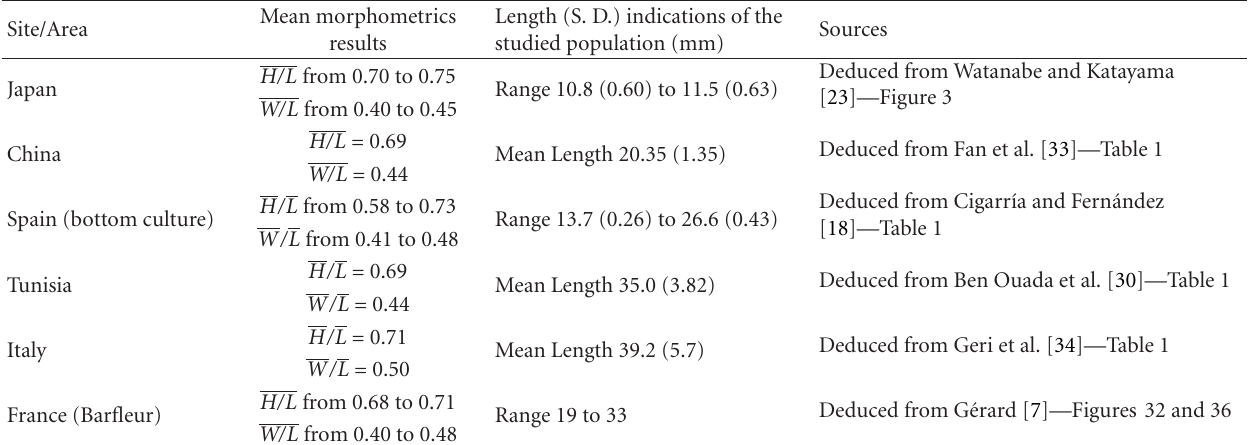
Table 3: Comparison of morphometric results with other sites including